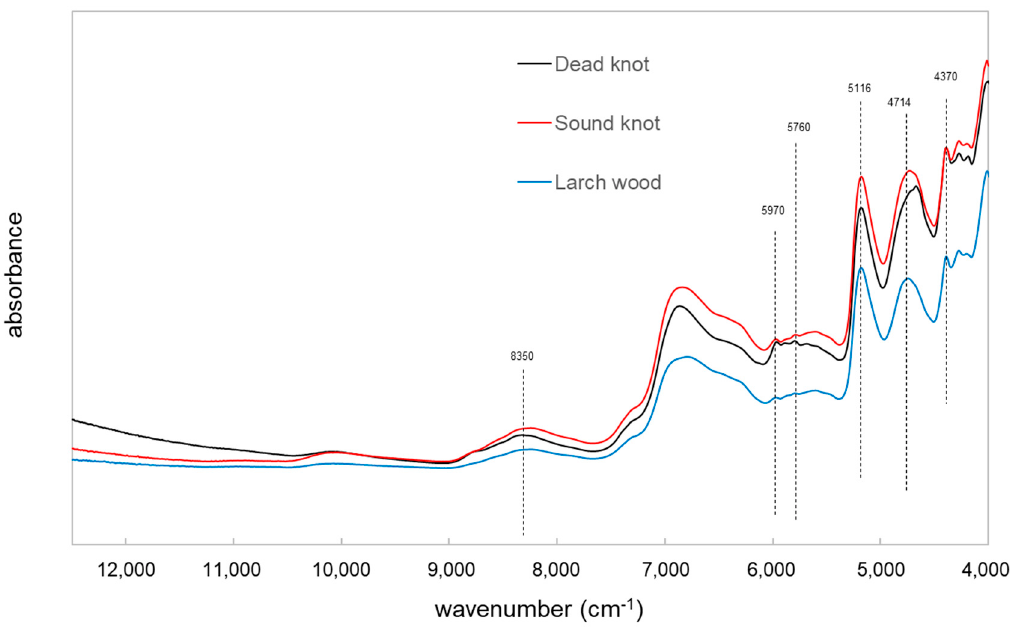
Figure 5. NIR spectra of larch wood, sound and dead knotwood.